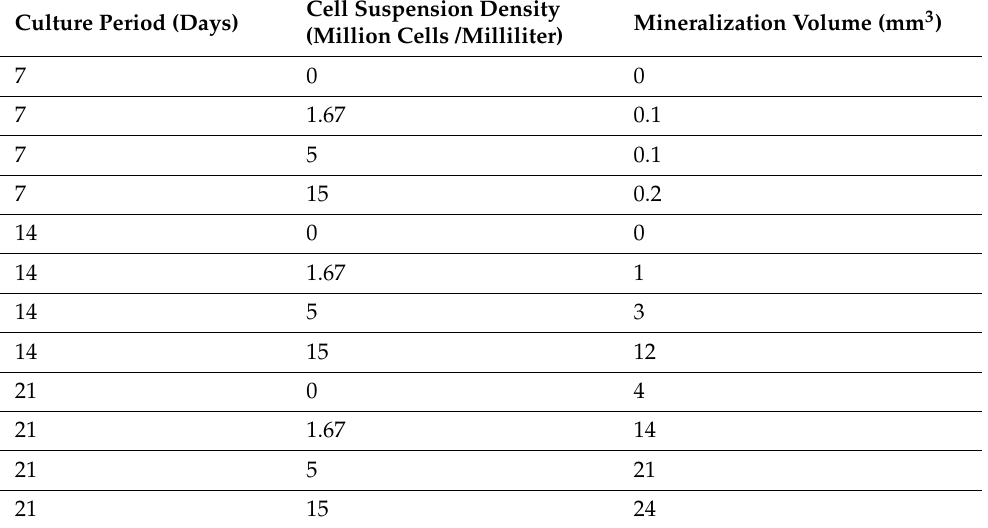
Table 1. Input Bioprinting